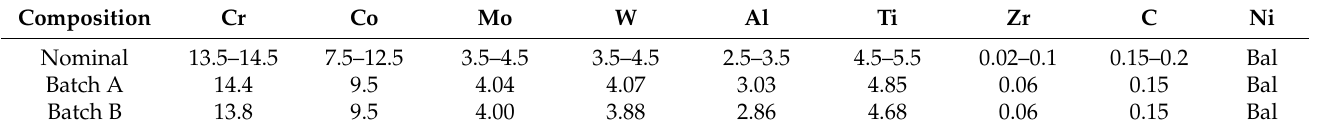
Table 2. Nominal [1] and measured compositions of the powders (all measurements are in %wt).